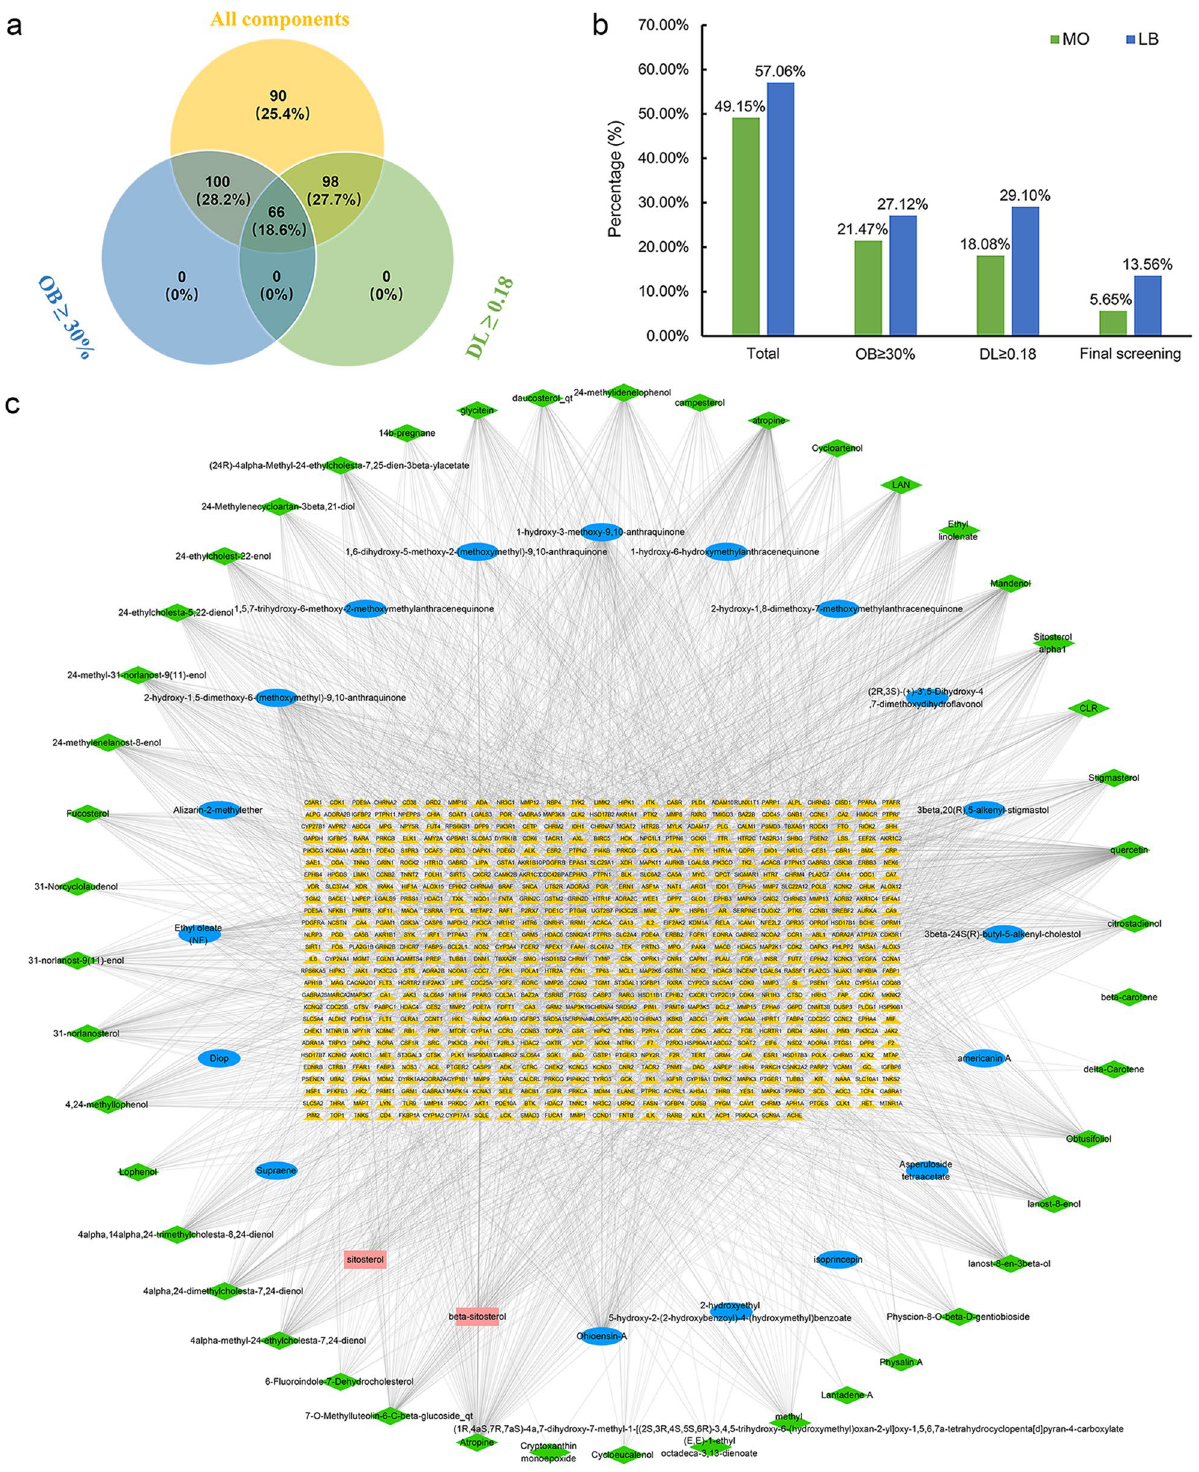
Figure 1. MOLBCH component-target network. ( a ) Venn diagram: 354 components (yellow section), and 66 bioactive components screened by two ADME-related models (blue section stands for the components of OB ≥ 30%, green section stands for DL ≥ 0.18). ( b ) Distributions of different herbs. ( c ) Construction of MOLBCH component-target visual network, including 736 nodes and 3034 edges. Green nodes and blue nodes stand for bioactive components from MO and LB respectively, yellow nodes stand for targets, pink nodes stand for beta-sitosterol and sitosterol. MO Morinda officinalis , LB Lycium barbarum